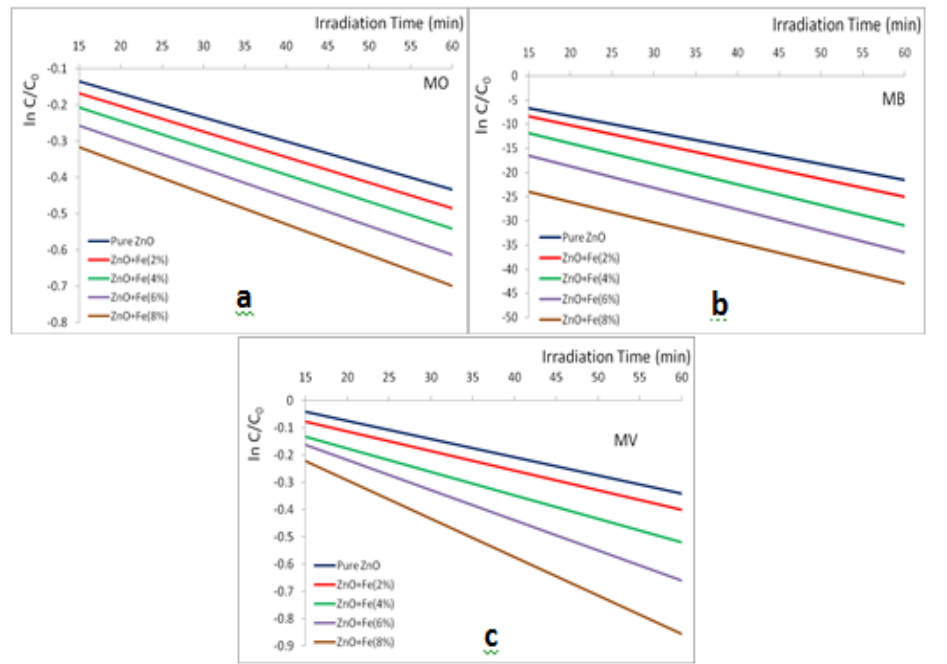
Fig.10: The relation between ln C /C MO, (b) MB and (c) MV solution.